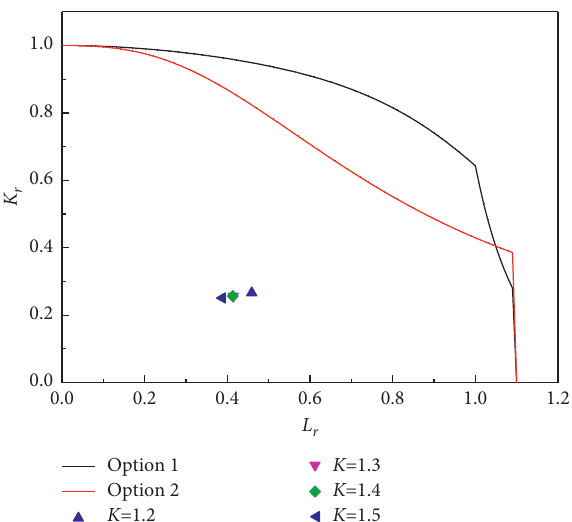
Figure 7: Effect of the top tension on the fracture performance of the riser.